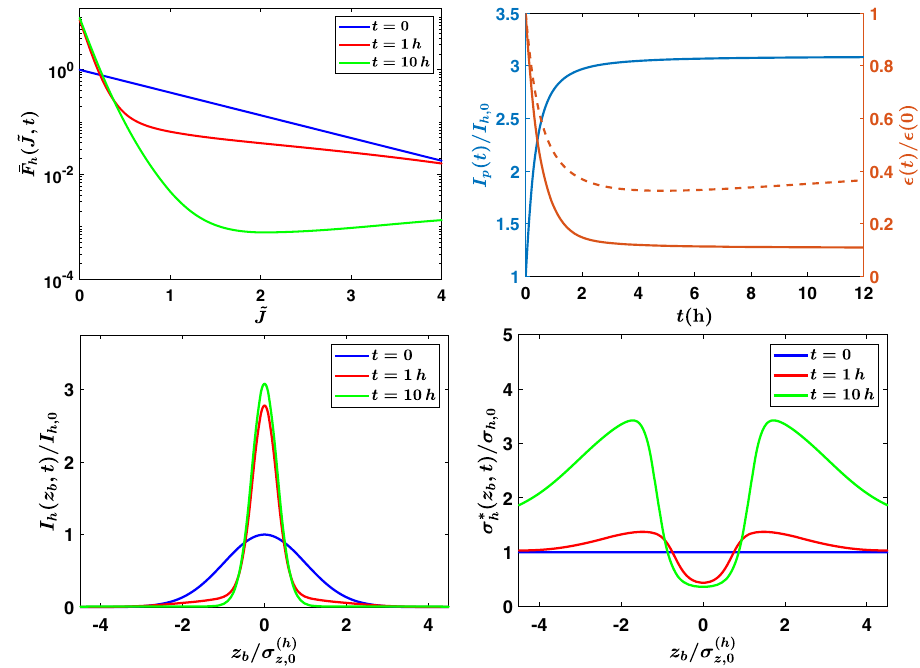
FIG. 4. Upper right: proton peak current (blue), total longitudinal emittance (brown-dashed) and 95% emittance (brown) as functions of time. For the remainder, moving counterclockwise, we plot the proton distribution function, current and local energy spread profiles at different times (data for the eRHIC parameter